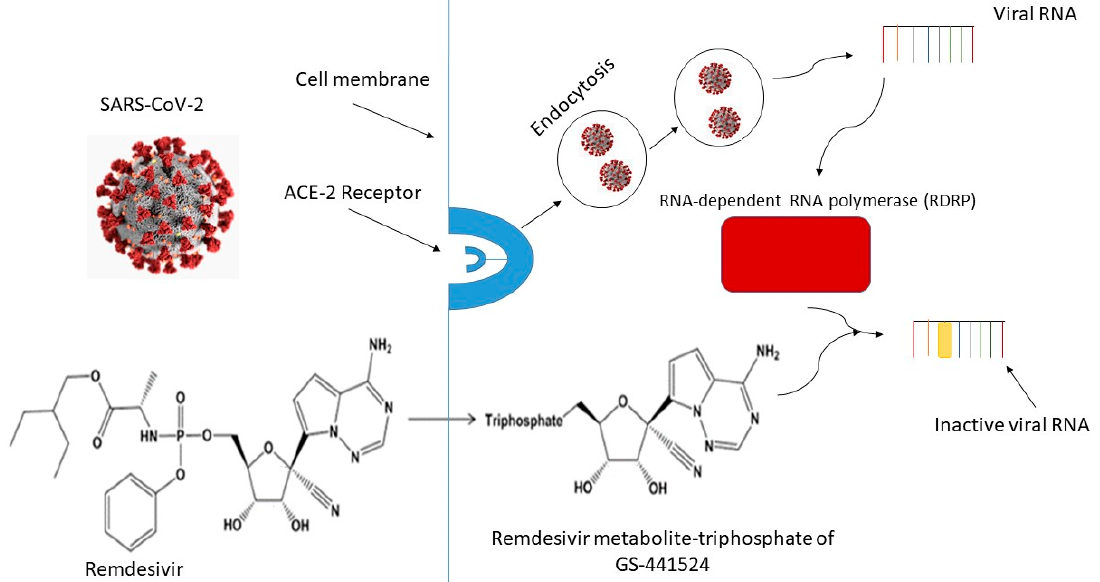
Figure 2. Remdesivir mode of action in inhibiting the RNA of the virus from replication in an infected cell.